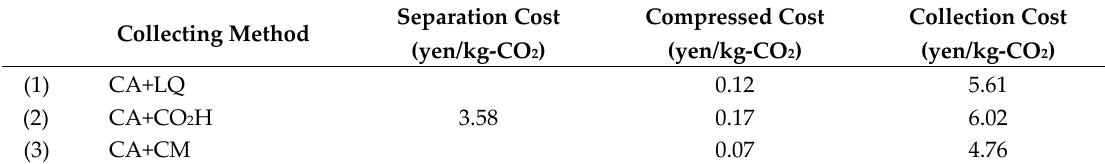
Table 8. Collection cost for each method.